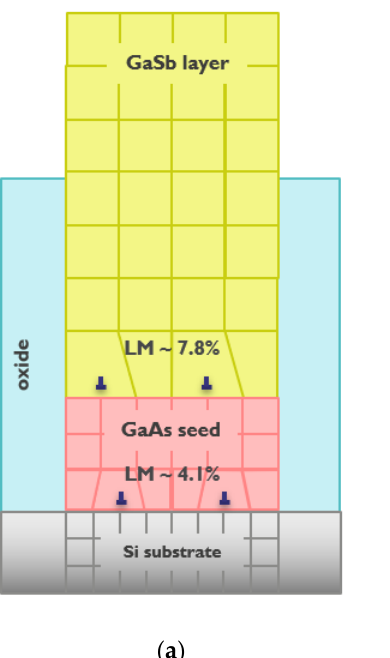
Figure 7. Threading dislocation density ( a ) and planar defect density ( b ) of GaSb nano-ridges as a function of underlying trench width based on ECCI. The di ff erent data groups indicated by a di ff erent color represent the three di ff erent integration approaches for GaSb.